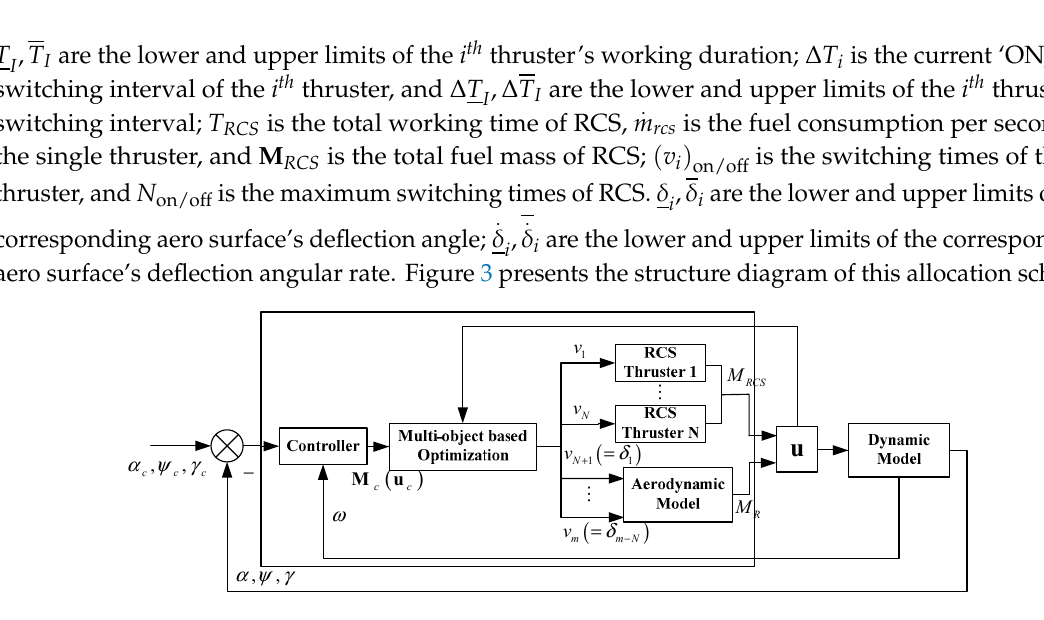
Figure 3. The structure diagram of the multi-object based optimal allocation scheme.